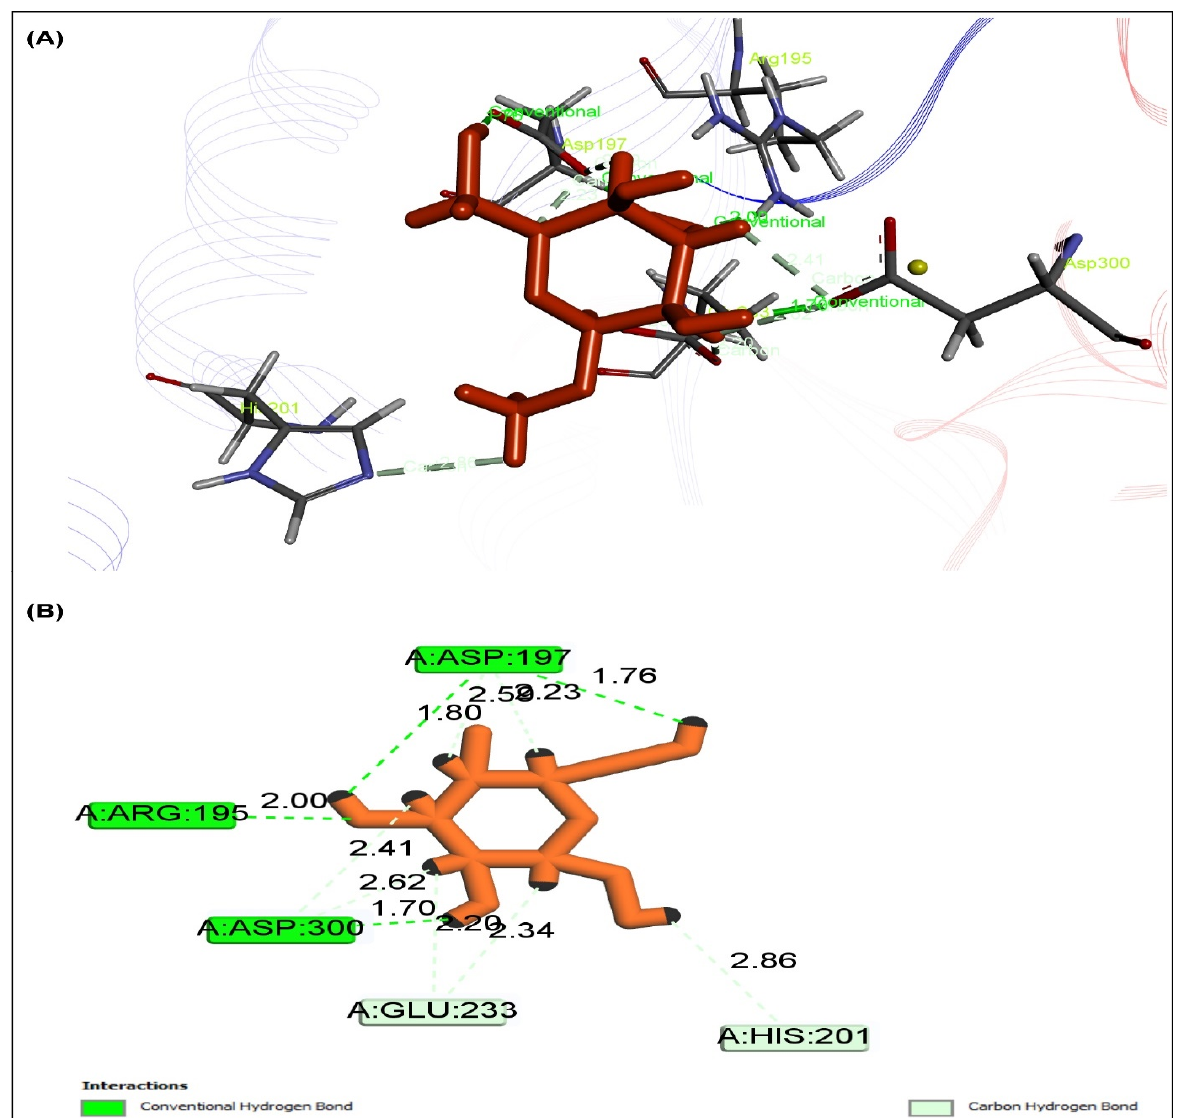
Figure 9. Docking study showed that the highest rank poses of methyl α - D -galactopyranoside docked with the active site 1PPI α -amylase for antidiabetic potential in ( A ) 2D and ( B ) 3D molecular interactions.